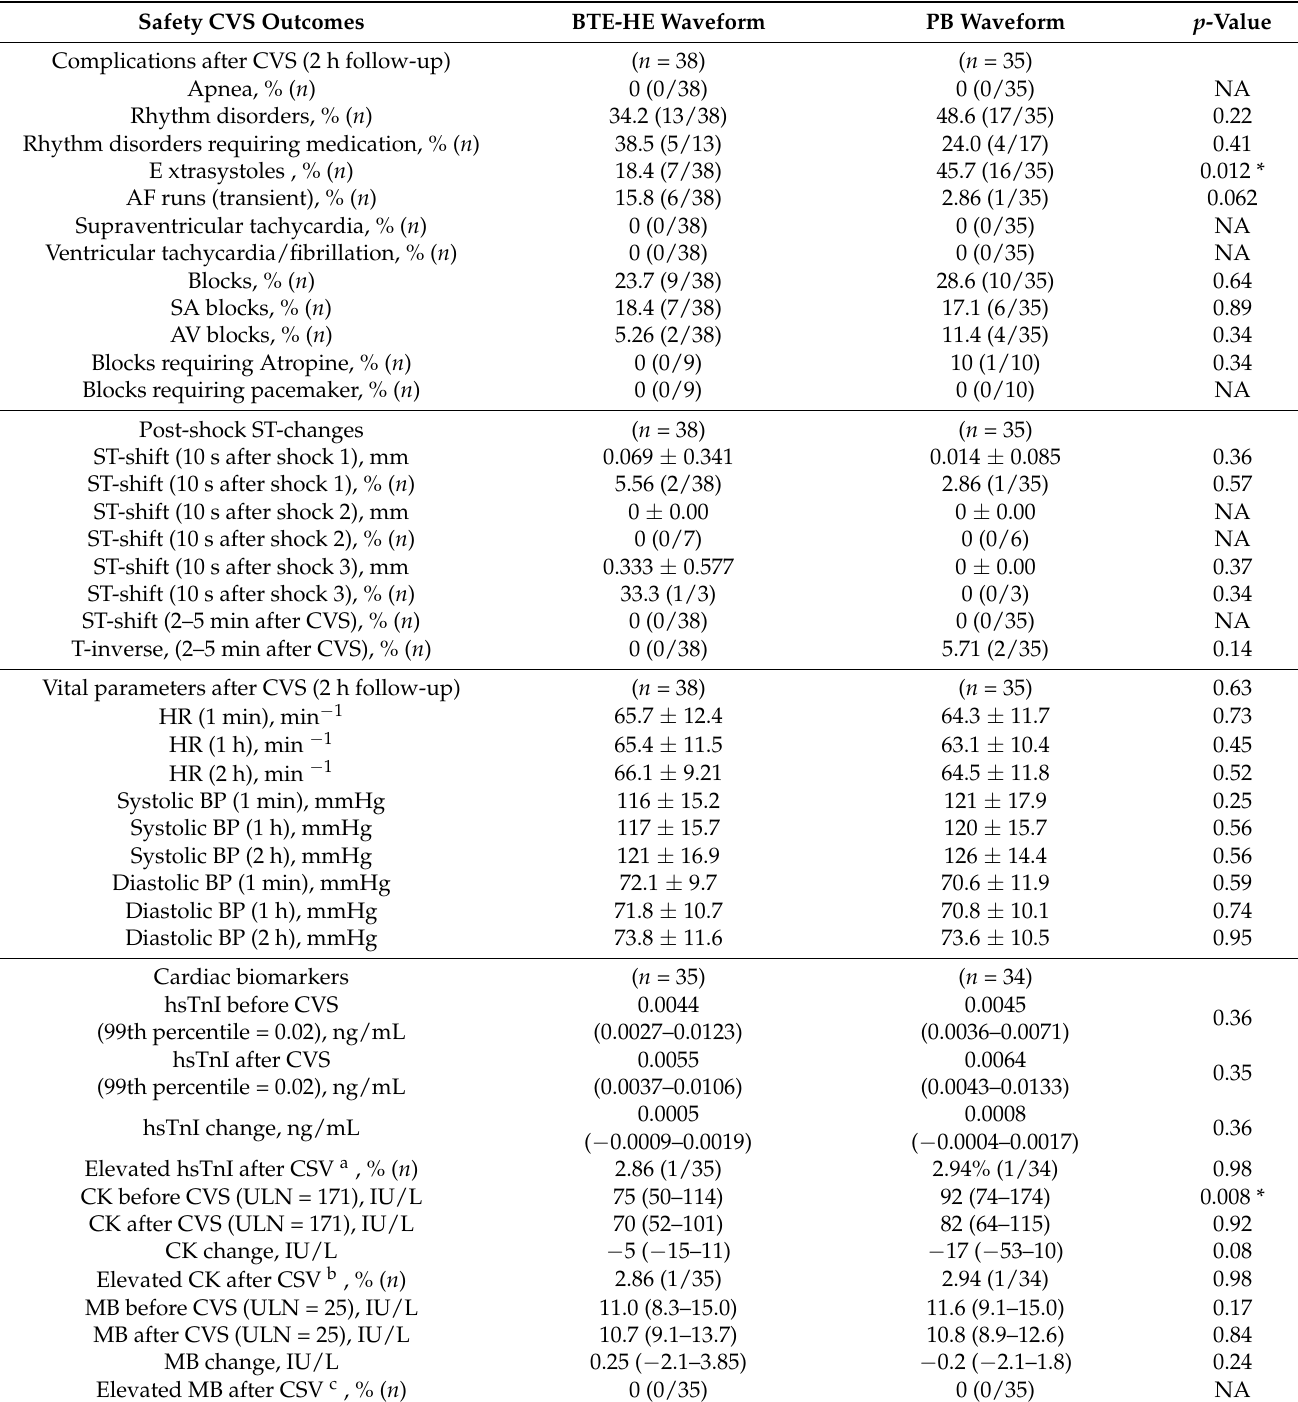
Table 3. Safety CVS outcomes. Data are expressed as mean ± standard deviation or median (inter-quartile range) for continuous variables, and % (number) for categorical